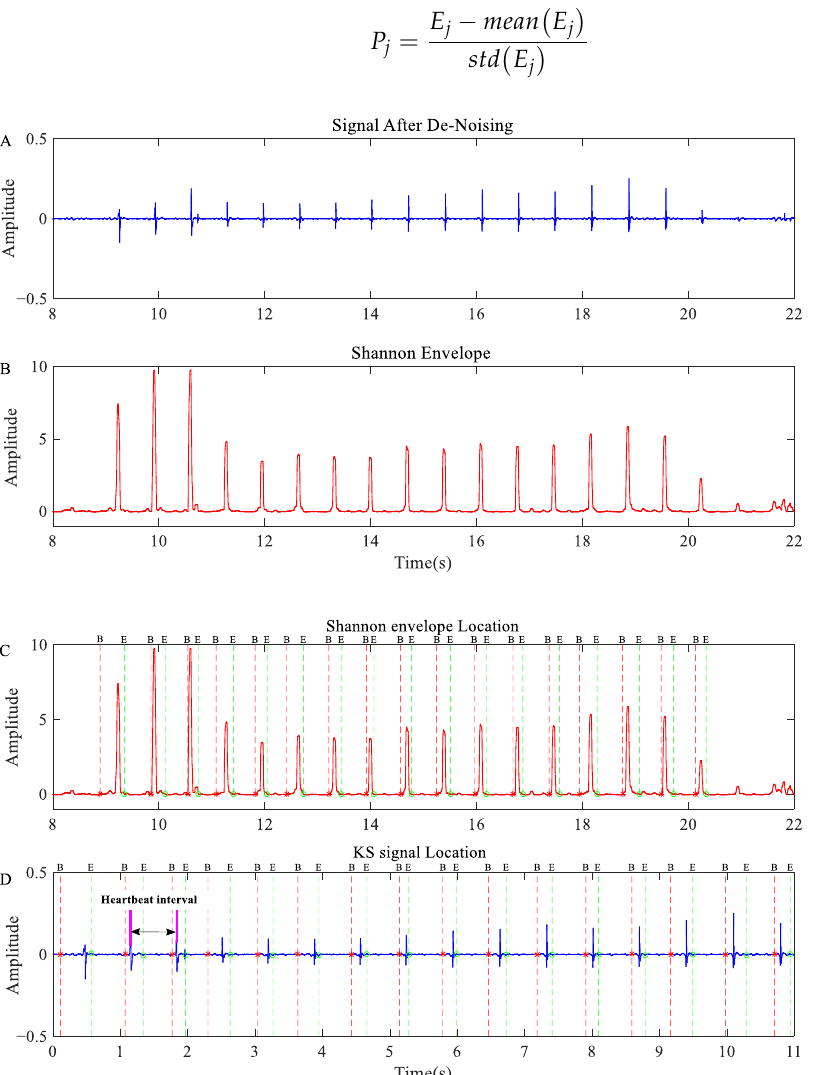
Figure 4. KS segmentation and location results: ( A ) de-noised KS signal; ( B ) Shannon envelope of the KS signal; ( C ) segmentation results of Shannon envelope; ( D ) segmentation results for KS. NOTE: The blue curve represents the KS signal ’ s time domain signal, while the red curve represents the KS signal ’ s Shannon envelope. B represents the start of KS, which is the same as the * added to the line, and E represents the end of KS, which is the same as the ° added to the line.